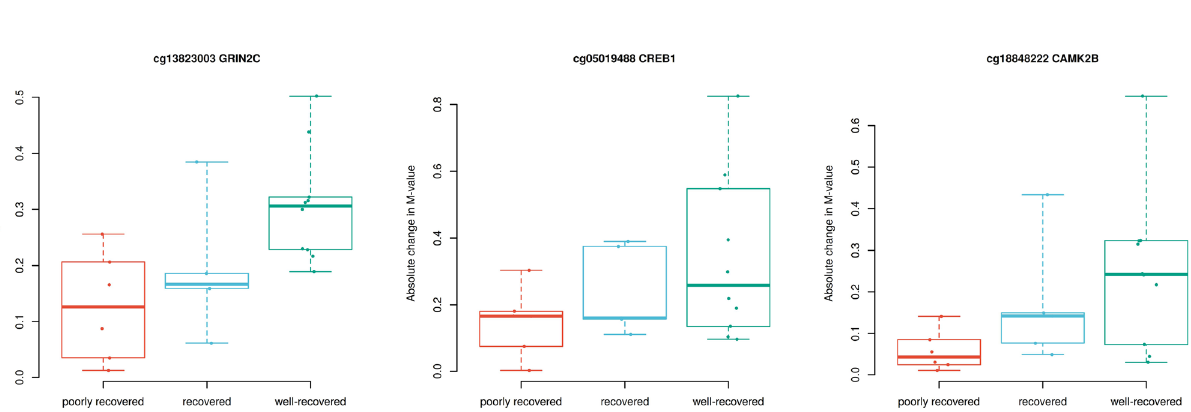
Figure 3. Boxplots of the three discovered differentially methylated CpG in the Reactome 2016 pathway “CREB phosphorylation through the activation of CaMKII” for the groups with different degree of recovery. Y-axis represents the absolute change in the M-values from work to vacation. Colors of the dots correspond to the different groups: red, poorly recovered; blue, recovered; green, well-recovered. The horizontal line is median, box is 25 to 75%, the whiskers denote data, and the dots represent individual